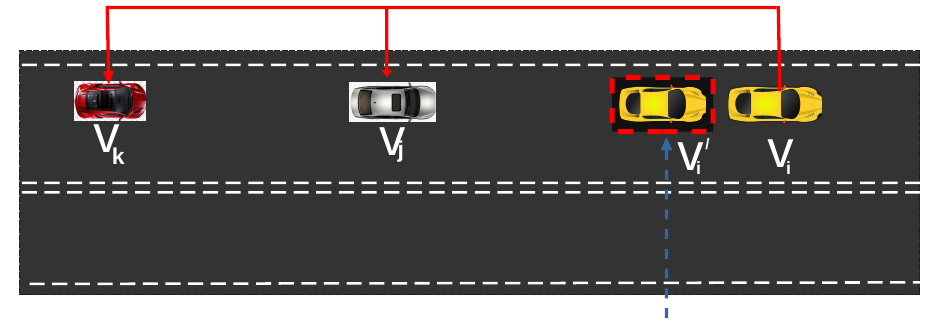
Figure 1. False Emergency ELectric Brake Light (EEBL) alert.